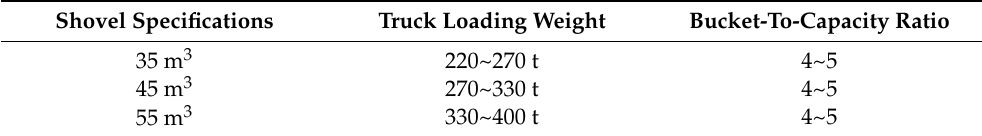
Table 4. Truck matching for different shovel specifications.